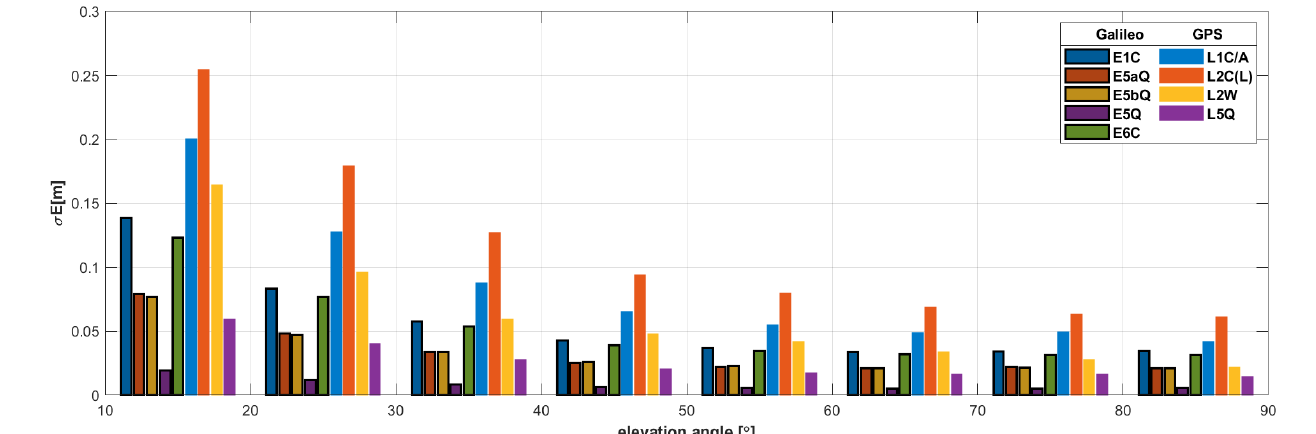
Figure 2. Standard deviation of code multipath error versus elevation at the WUT2 site.